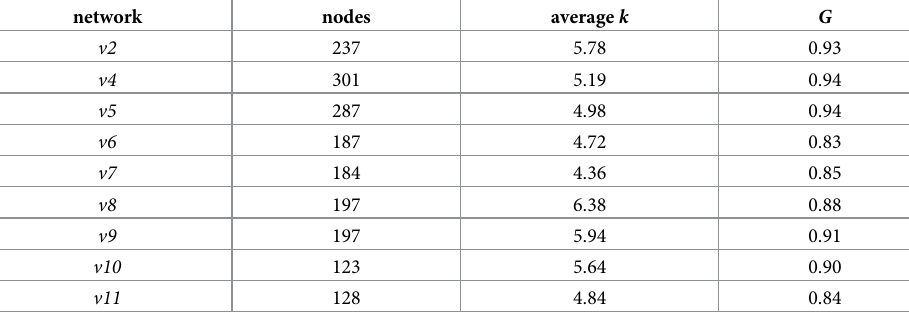
Table 1. Basic properties of the developer collaboration